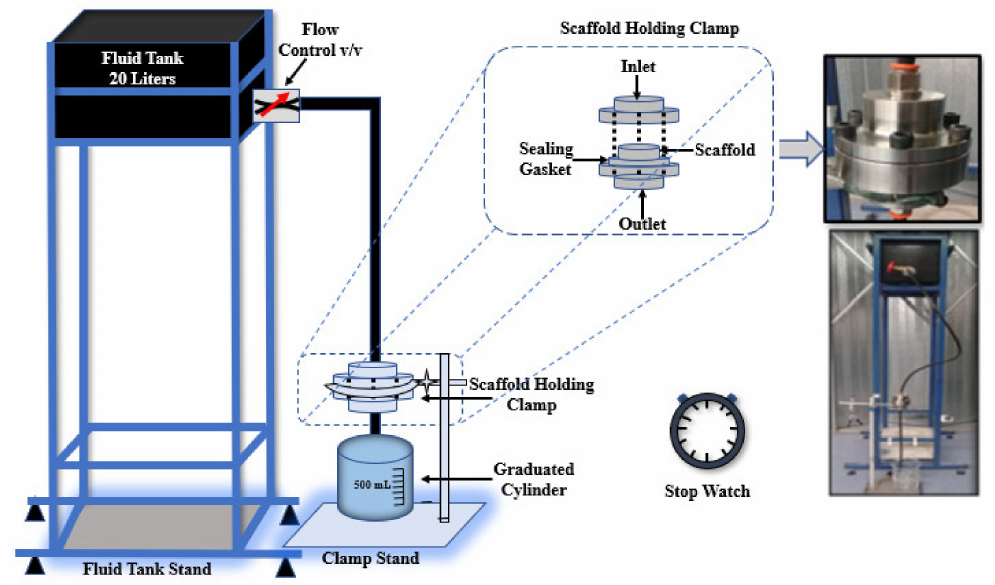
Figure 2. Experimental setup for the 3D-printed porous bone scaffold permeability